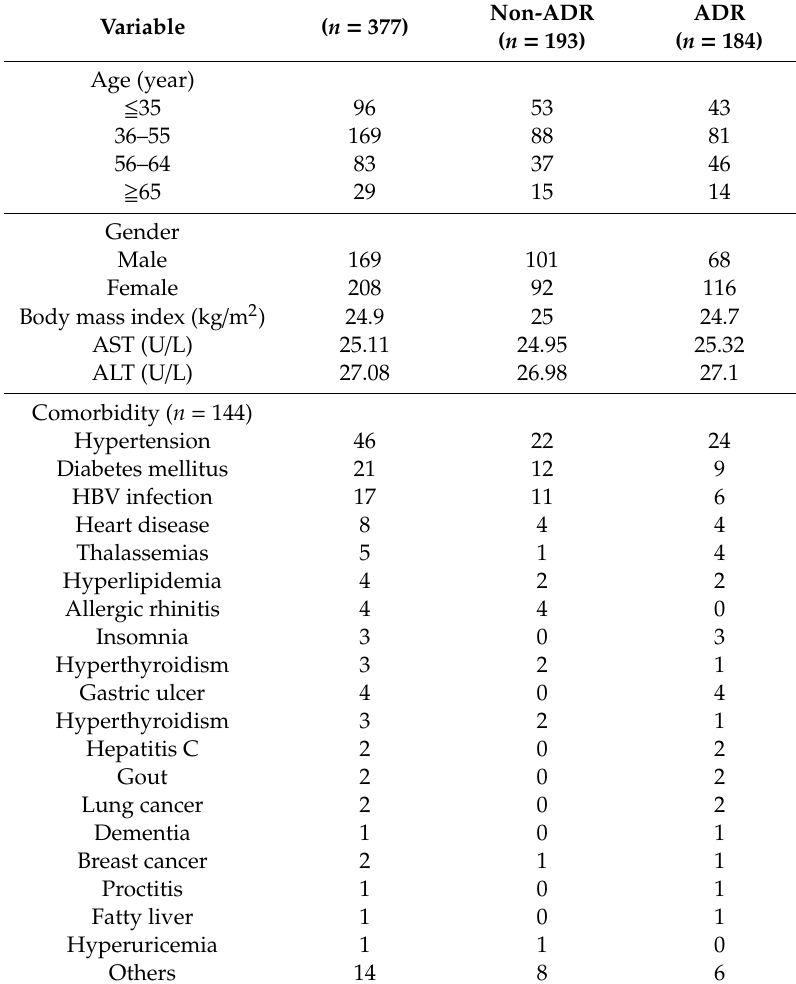
Table 2. Clinical characteristics and laboratory data in 377